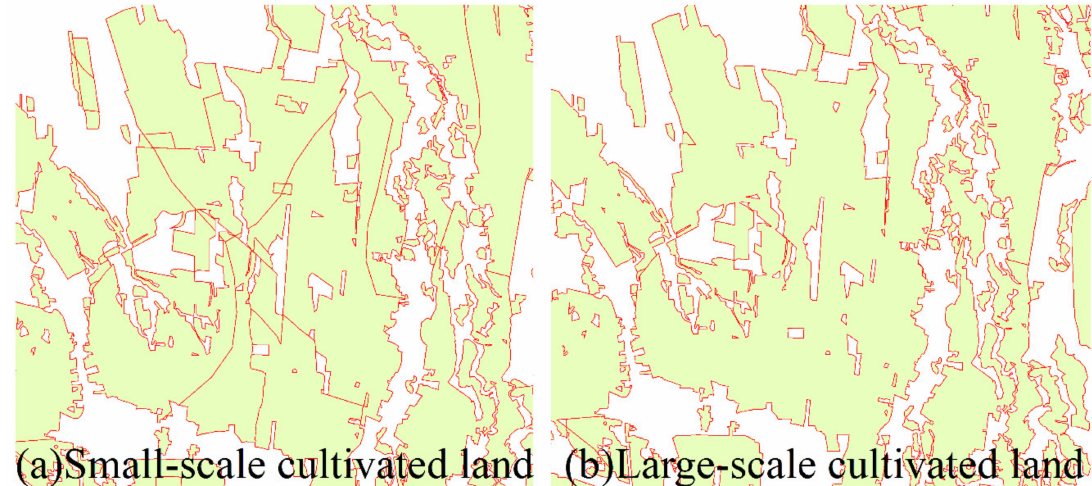
Figure 2. Schematic diagram for cultivated land before and after aggregation. ( a ) Small-scale cultivated land before aggregation. ( b ) Large-scale cultivated land after